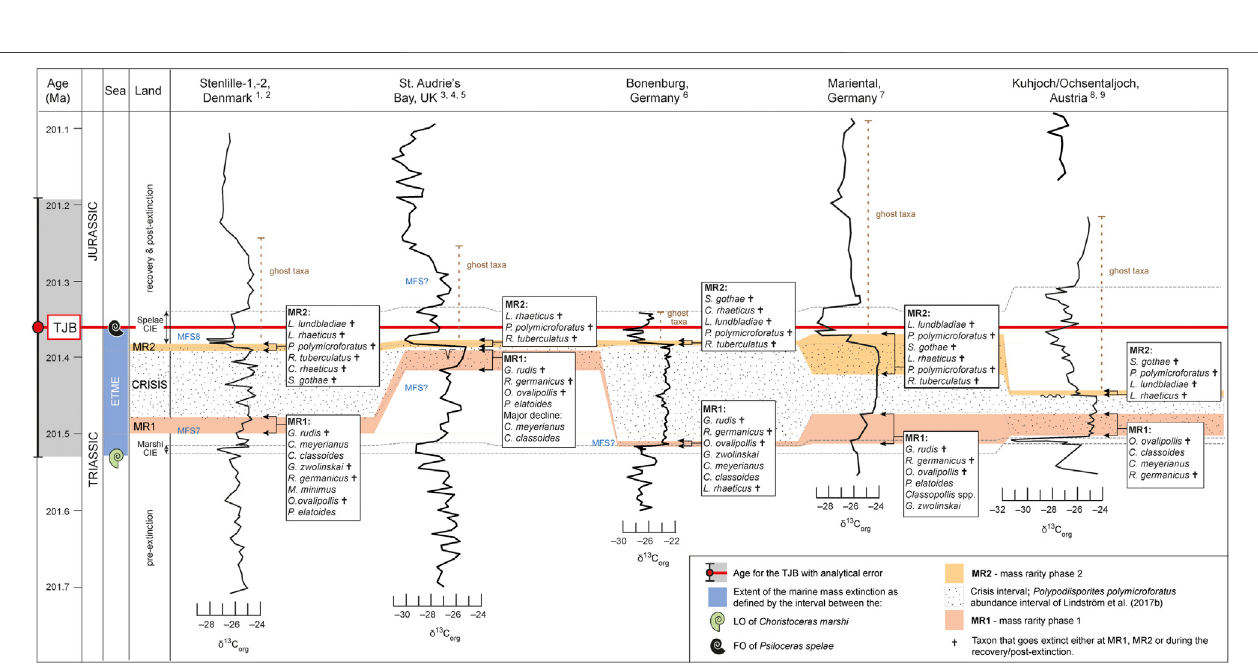
FIGURE 5 | Correlation of δ 13 C org -records, mass rarity phases (MR1 and 2) and crisis interval [i.e. Polypodiisporites polymicroforatus abundance interval of Lindström et al. (2017b)] in Stenlille-1, St. Audrie ’ s Bay, Bonenburg, Mariental and Kuhjoch. The recorded taxa are also shown in Table 3 . Numbers after the localities refer to the following references: 1. Lindström et al. (2017b), 2. Lindström et al. (2021), 3. Hesselbo et al. (2002), 4. Hesselbo et al. (2004), 5. Bonis et al. (2010), 6. Gravendyck et al. (2020); Heunisch et al. (2010), 8. Bonis et al. (2009), 9. Hillebrandt et al. (2013). The correlation is based on Lindström et al. (2017b), Lindström et al. (2021).